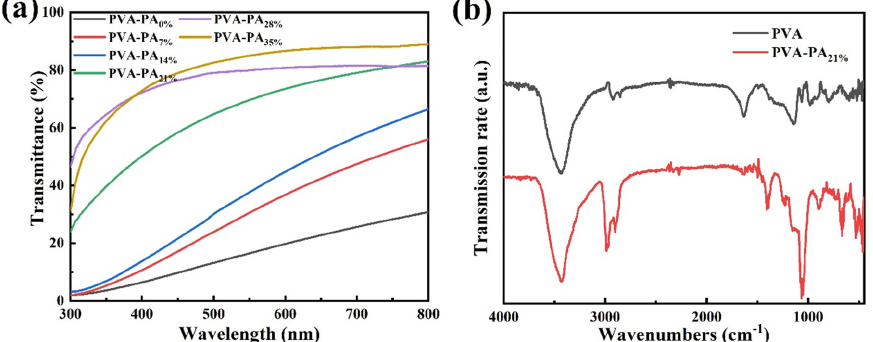
Figure 6. ( a ) UV-vis spectra of PVA-PAx hydrogels with different PA contents. ( b ) FT-IR spectra of pure PVA and PVA-PA 21% .